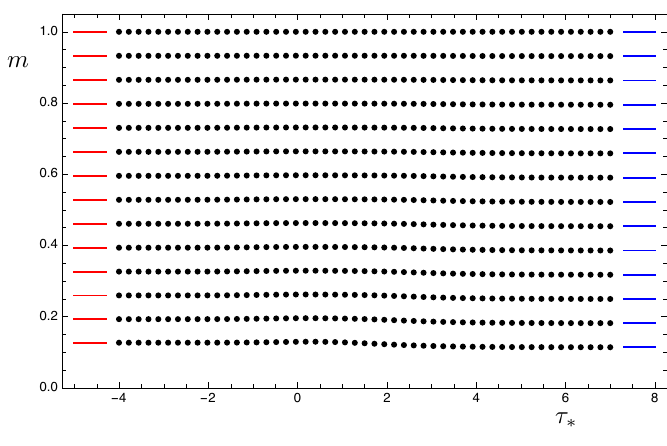
Figure 4 . Mass spectrum m of spin-2 states as a function of (cid:28) included in the plot, compared to the spin-2 spectrum of B OP